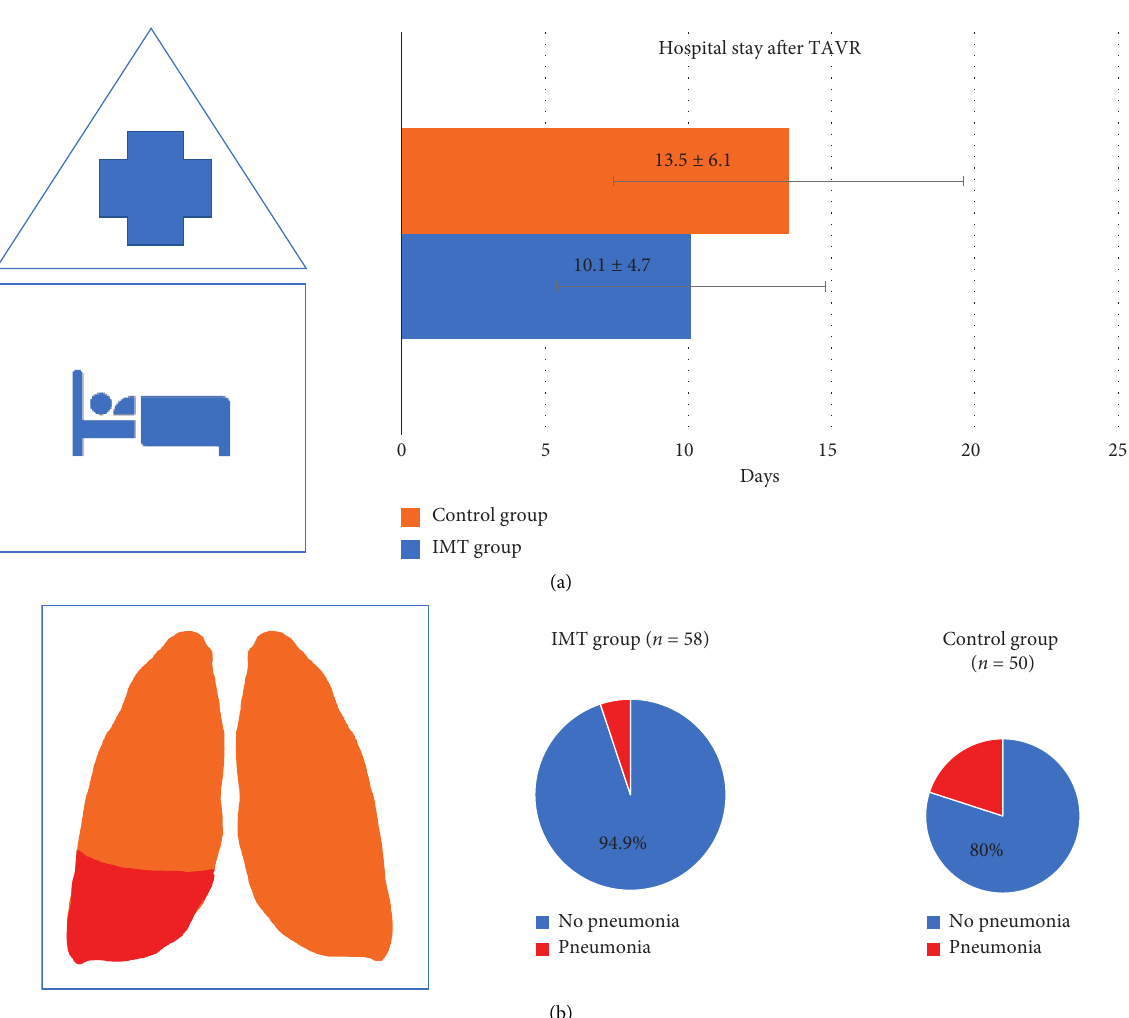
Figure 3: (a) Hospital stay after TAVR and comparison between groups ( p � 0 . 02 ) ; (b) incidence of pneumonia and comparison between IMT (left) and control (right) group ( p � 0 . 02 )